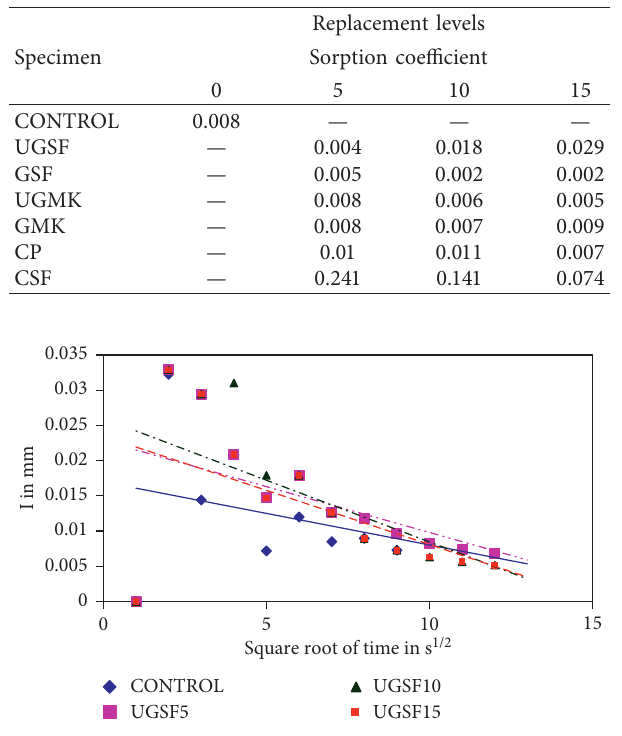
Figure 13: Sorption coefficient of UGSF.